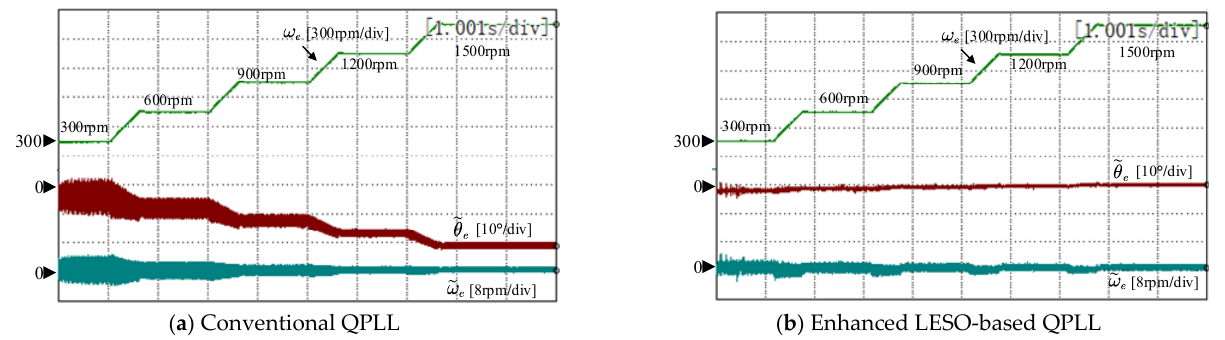
Figure 14. Experimental results of the real speed, the position estimation error, and the speed esti- mation error at different operating speeds under no load.